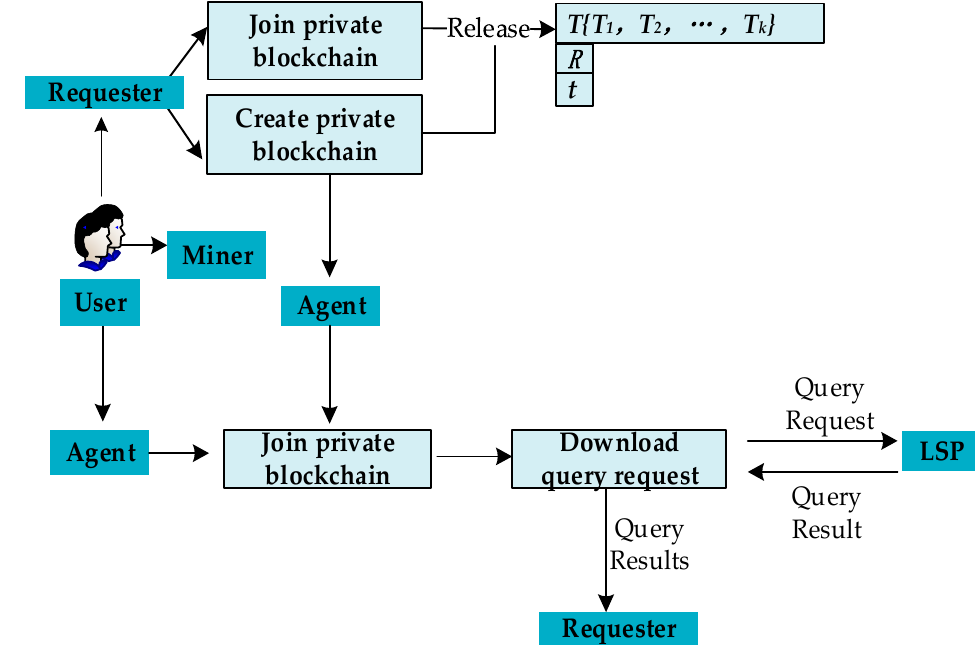
Figure 3. The general process of the proposed framework.